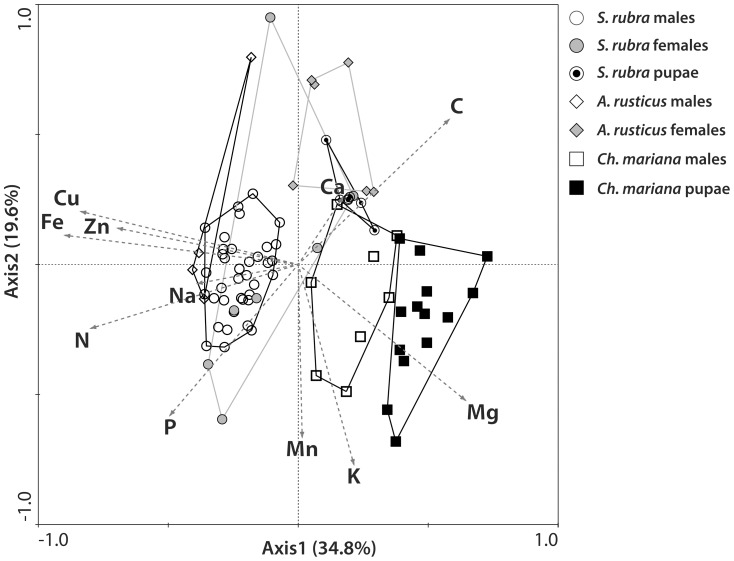
Multivariate analysis of stoichiometric relations in three species of xylophagous beetles based on the 11 studied elements – PCA plot (first two axes).